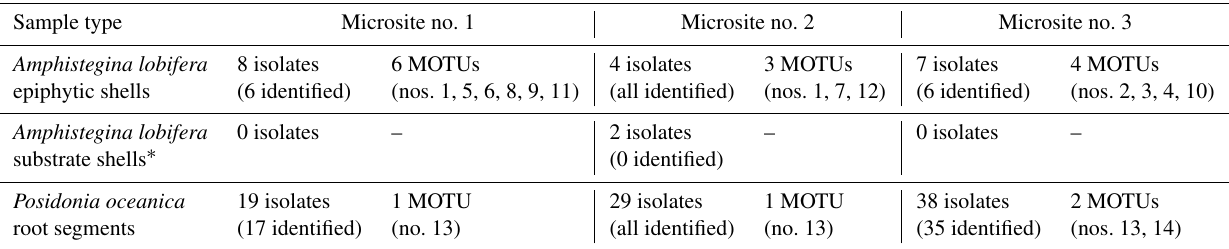
Table 2. Results of mycobiont isolation from shells of the foraminiferan Amphistegina lobifera and roots of the seagrass Posidonia oceanica . The mycobionts were isolated into pure cultures and the molecular operational taxonomic units (MOTUs) were delimited as described in Sect. 2.